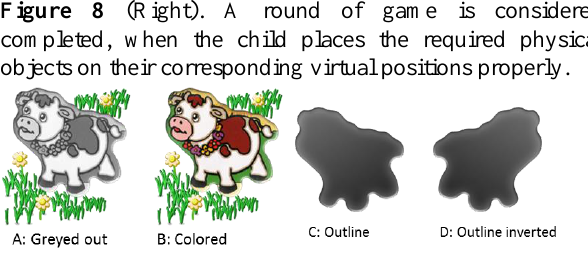
Figure 7. Alternative instantiations of virtual